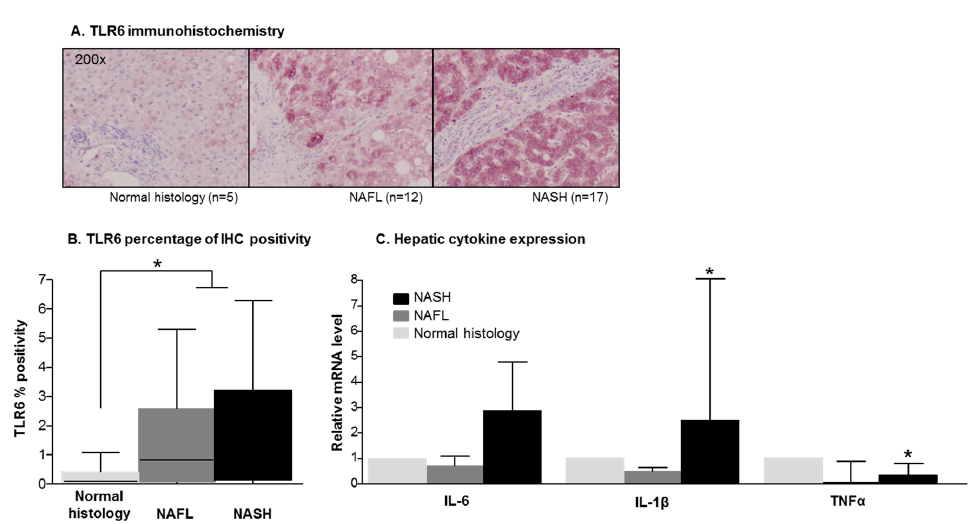
Figure 2. ( A ) Hepatocyte immunohistochemistry mean percentage of expression of TLR6 is enhanced in NAFL and NASH patients compared to morbidly obese with normal histology; ( B ) median percentage of TLR6 immunohistochemistry positivity in liver biopsies. Median positivity is significantly higher in the overall cohort of patients with NAFLD compared to those who displayed normal histology (median (IQR) positivity in NAFLD 0.56 (0.11–2.78) compared to median positivity in normal histology 0.09 (0.01–0.39); p = 0.04). No differences were found in the expression of TLR6 in the hepatocytes of NAFL compared to NASH patients; ( C ) hepatic gene expression profile of IL-6, TNF α and IL1 β . Relative mRNA levels were analyzed in NAFL and NASH compared to patients with normal liver histology. All three cytokines were more expressed in the livers of patients with NASH compared to patients with normal liver histology (median (IQR): IL-1 β : 2.48 (1.04–8.03) in NASH compared to 0.47 (0.38–0.63) in NAFL; p = 0.01; TNF: 0.33 (0.15–0.80) in NASH compared to 0.05 (0.02–0.88) in NAFL; p = 0.03), although in the case of IL-6, this difference did not reach statistical significance. * p < 0.05.